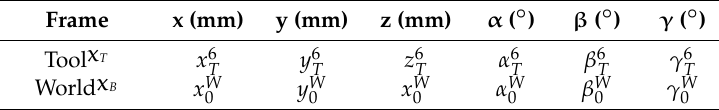
Table 4. Tool and base nominal parameters.